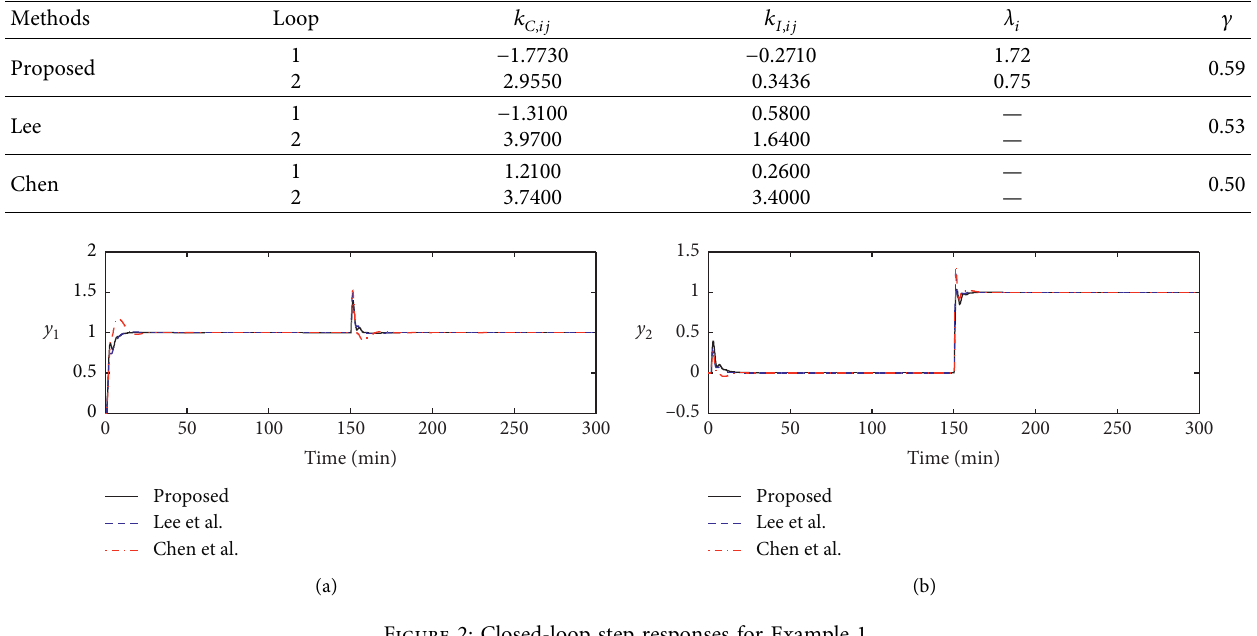
Figure 2: Closed-loop step responses for Example